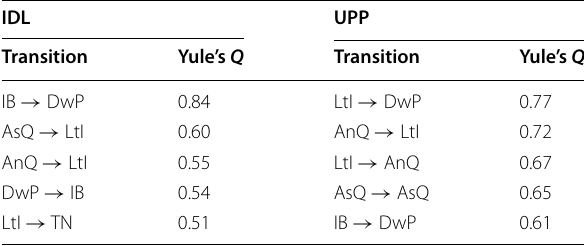
Transitions with the top five Yule’s Q scores were presented